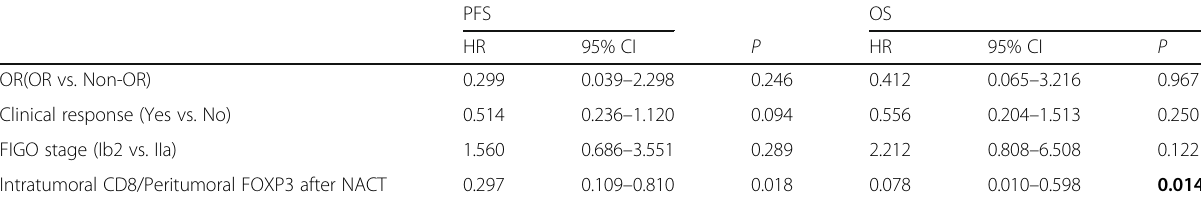
Table 3 Multivariate analysis of clinical parameters and TILs for cervical cancer survival after NAC